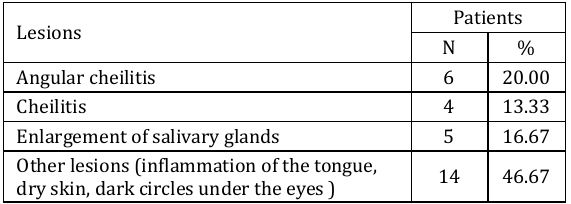
Table 5. Lesions in patients with eating